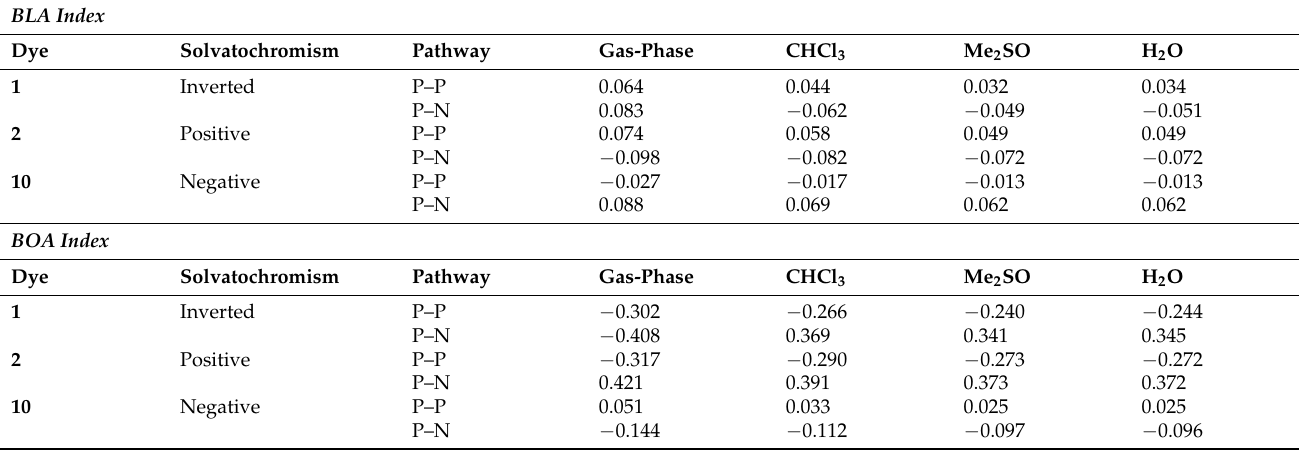
Table 1. BLA (Å) and BOA index values for solvatochromic dyes 1 (inverted), 2 (positive), and 10 (negative) computed with the two pathways, P–P and P–N, as shown in Figure